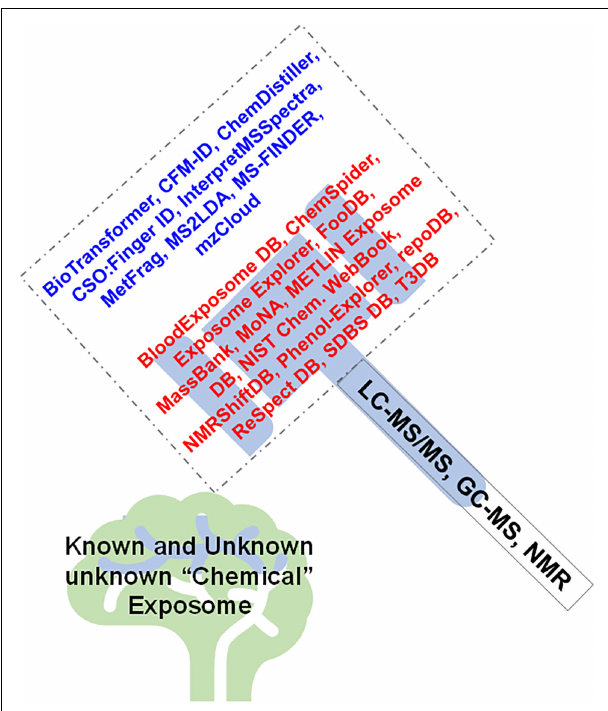
FIGURE 3 | Mass spectrometry and spectroscopy provide the necessary analytical tools that aid in capturing the aging “exposome,” which when processed by the software tools, resources, and databases enable to “crack” (identify) the known and unknown chemical